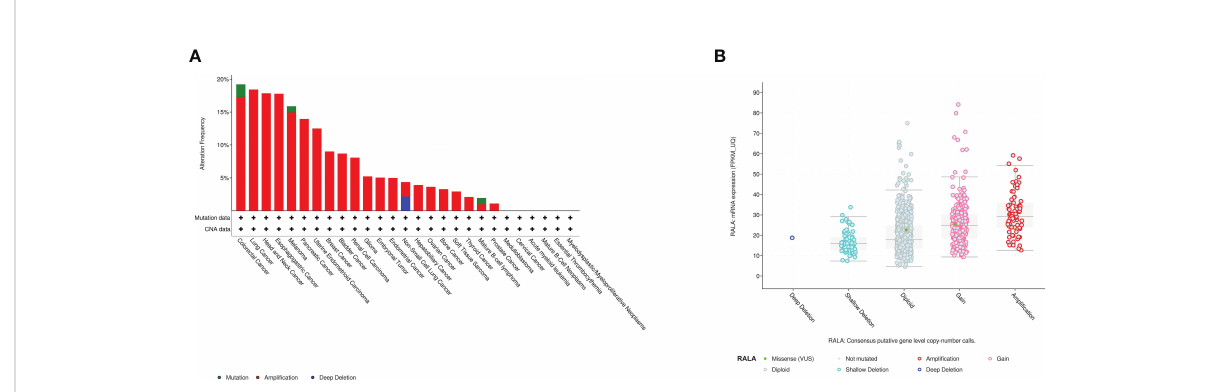
FIGURE 5 Mutant aspects of RALA. (A) Mutation types of RALA gene in pan-cancer. (B) The correlation between the mRNA obtained by RALA gene transcription in pan-cancer and the variation of tumor copy number (CNA).